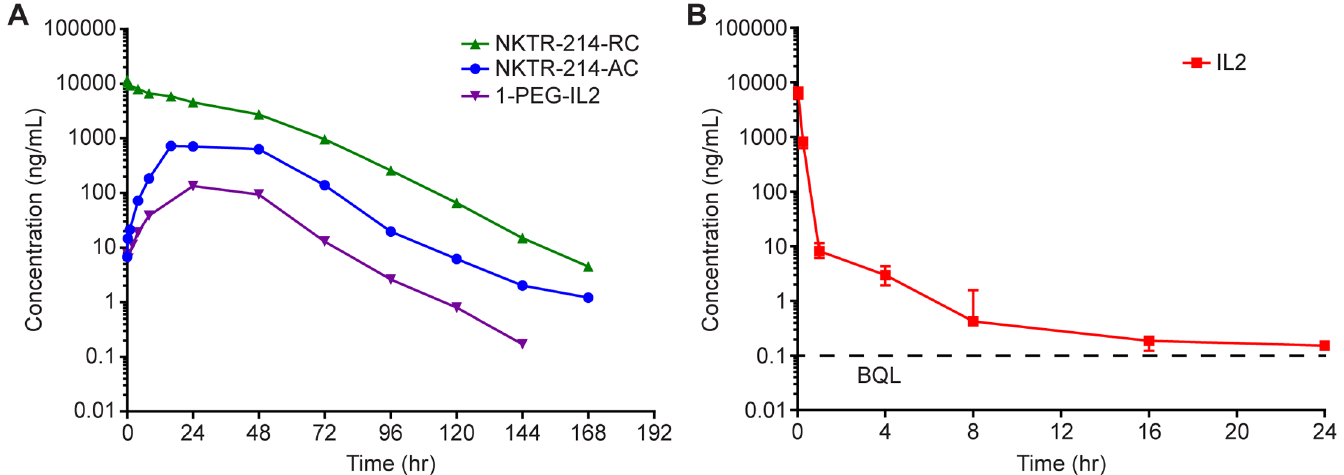
Fig 5. A single dose of NKTR-214leads to sustained exposure. A. Semi-logarithmic plot of plasma concentration vs. time curves for NKTR-214-RC, NKTR-214-AC, and 1-PEG-IL2 after administration of NKTR-214 B. Semi-logarithmic plot of plasma concentration of IL2 after administration of aldesleukin. https://doi.org/10.1371/journal.pone.0179431.g005 simulated species are summarized in Table 3. The summation of simulated concentration-